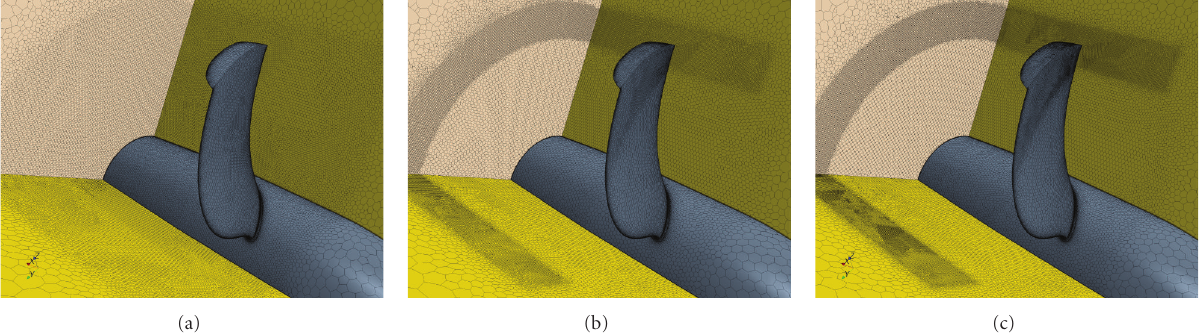
Figure 7: Mesh arrangements for propeller wake analysis. (a) Base mesh. (b) Medium mesh. (c) Finer